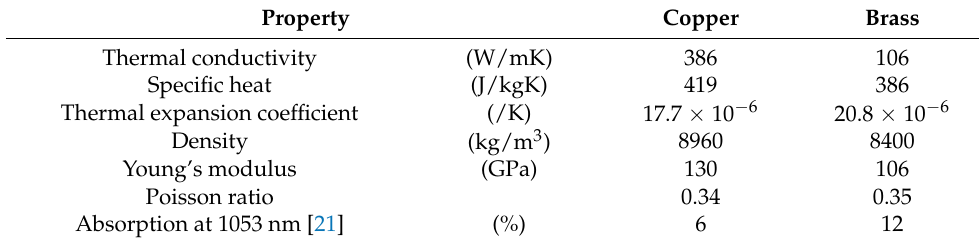
Figure 1. Experimental setup: ( a ) evaluated samples; ( b ) testing layout. Table 1. Thermal and mechanical properties of copper and brass.